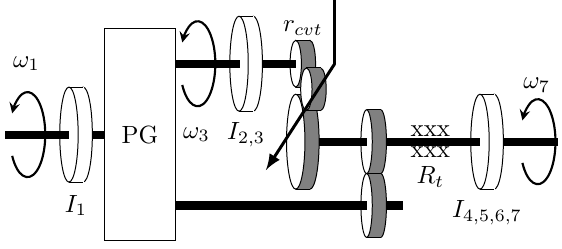
Figure 12. Simplified IPM of the transmission system.